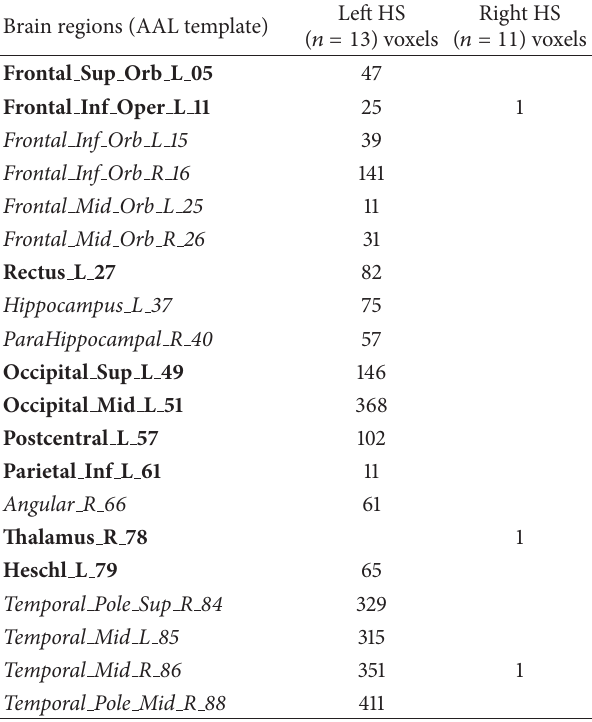
Table 2: Regions of GMV loss in left HS and right HS patients compared to healthy controls (FWE corrected, 𝑝 < 0.05; cluster > 10